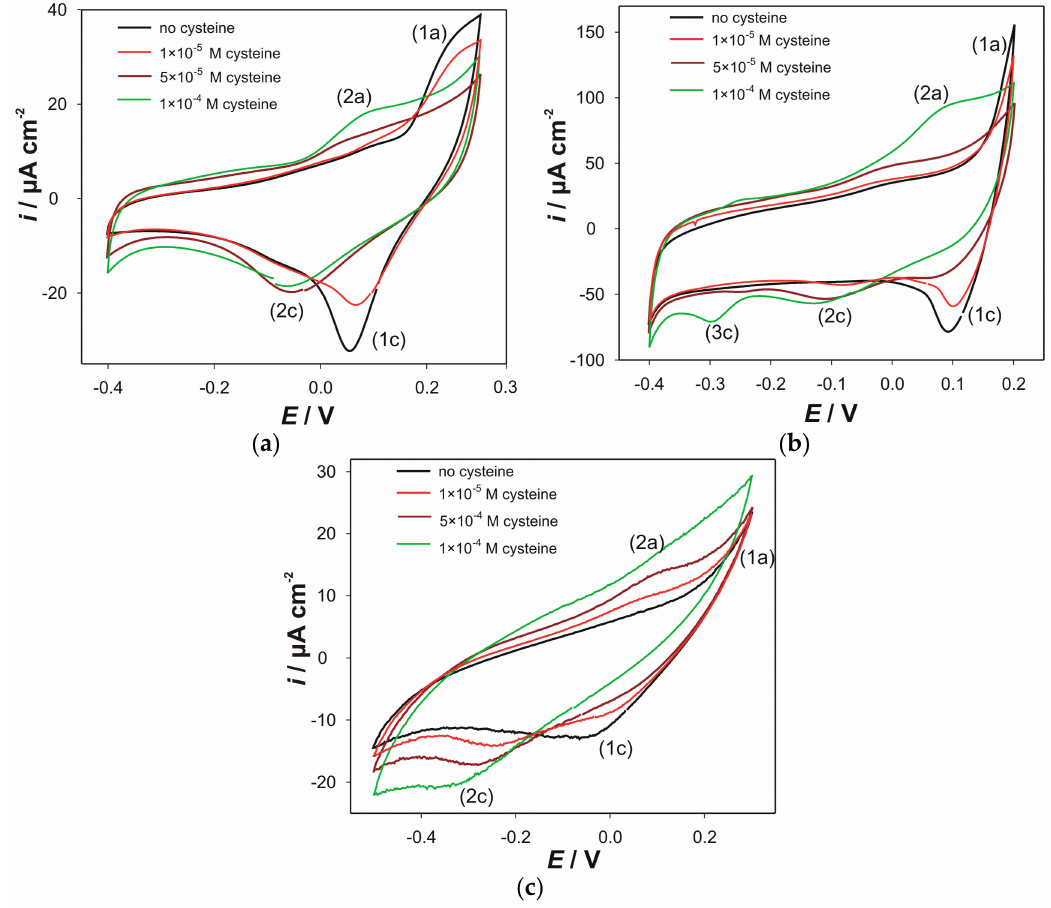
Figure 2. CVs obtained in 90 mL 0.1 KNO 3 + 10 mL 0.1 M phosphate buffer (pH 7) without and in the presence of various cysteine concentrations (successive addition of cysteine): ( a ) electrode “AC0.5S”; ( b ) electrode “ACS”; ( c ) electrode “AC1.8S” . Scan rate 25 mV s − 1